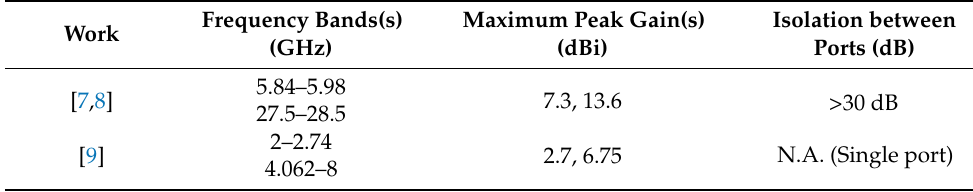
Table 2. Comparison of antenna performance among multi-band antennas.